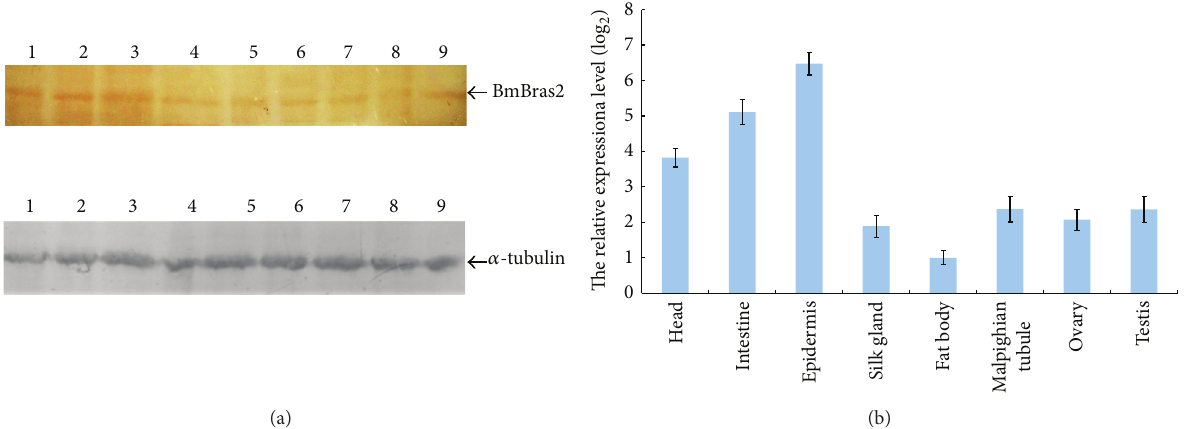
Figure 4: Distribution of BmBras2 in different fifth instar larvae tissues. (a) tissue distributions of BmBras2 by western blotting; 1, head; 2, intestine; 3, epidermis; 4, silk gland; 5, fat body; 6, malpighian tubule; 7, ovaries; 8, testis; 9, purified rBmBras2. (b) tissue distributions of BmBras2 analyzed by real-time PCR. Sg, silk gland; Fb, fat body; Mt, malpighian tubule. The relative expression level was calculated by using 2 −ΔΔ CT here ΔΔ CT = (CT, BmBras2 -CT, 18S rRNA) for different tissues and (CT, BmBras2 -CT, 18S rRNA) fat